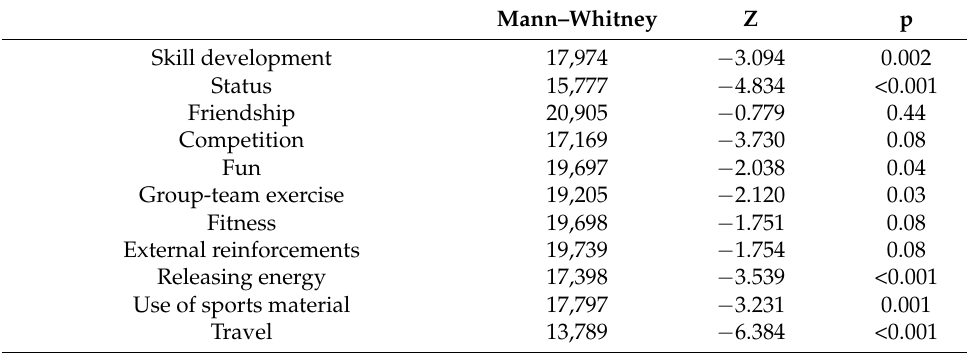
Table 4. Mann–Whitney test for each motivational factor between EA and NEA.